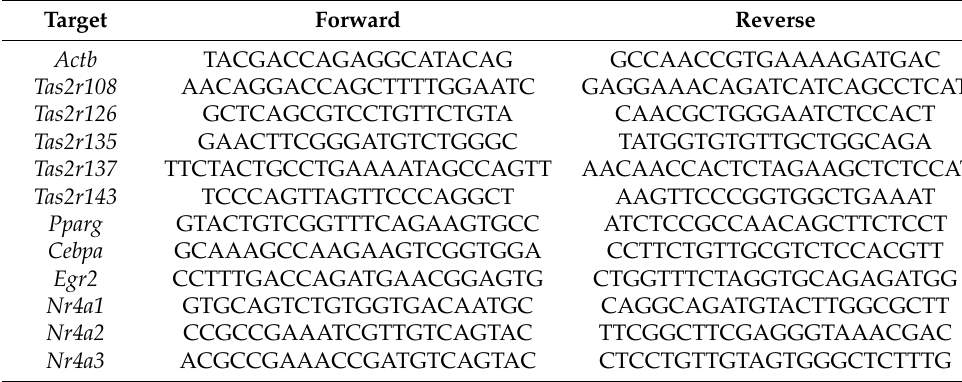
Table 2. Primers used in this